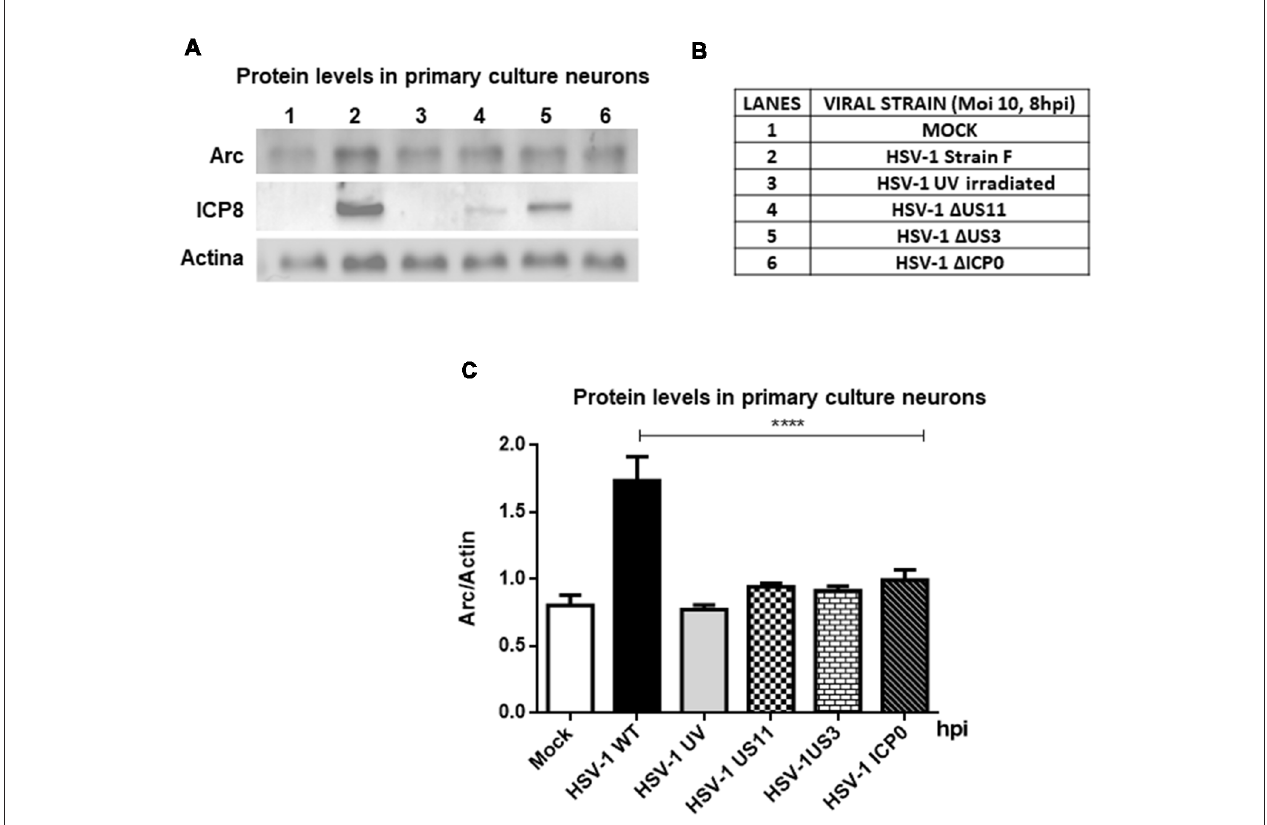
FIGURE 4 | Viral replication is mandatory to induce an increase in Arc protein levels. (A) Immunoblot analyses showing Arc, ICP8, Actin and GAPDH proteins, in either mock or HSV-1-infected neurons (lanes 1–6) with a MOI of 10 and at 8 hpi. (B) Table indicating the strains tested including Strain F (wild-type HSV-1) and different replicative-defective HSV-1 mutants and UV-irradiated (inactivated) HSV-1. (C) After gel scanning and densitometry quantitation, the results were expressed as the ratio of Arc protein levels in respect to total Actin. The results shown are representative of three independent experiments. ∗∗∗∗ p > 0.0001 (analyzed by one-way ANOVA, followed by Tukey’s multiple comparisons